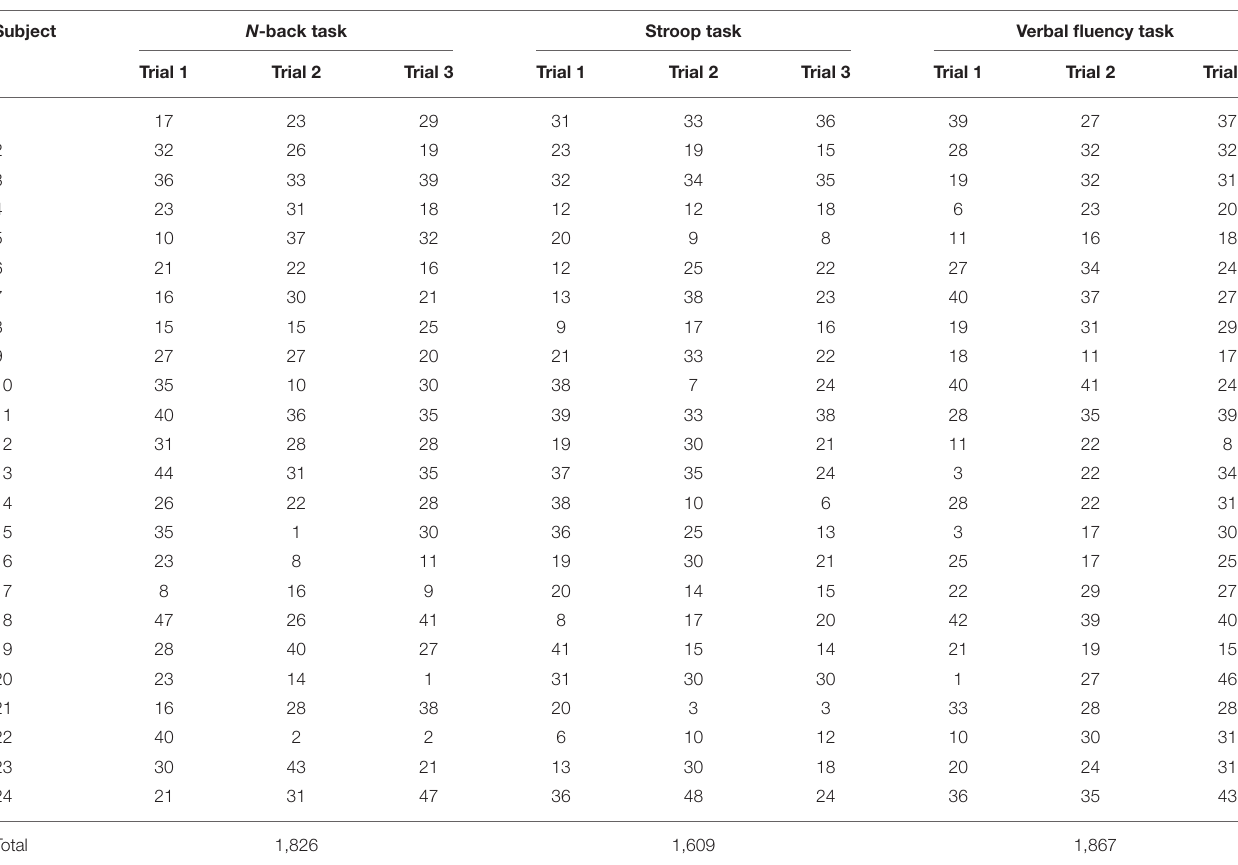
TABLE 2 | Number of ROI channels of each subject for three mental tasks (i.e., N -back task, Stroop task, and verbal fluency